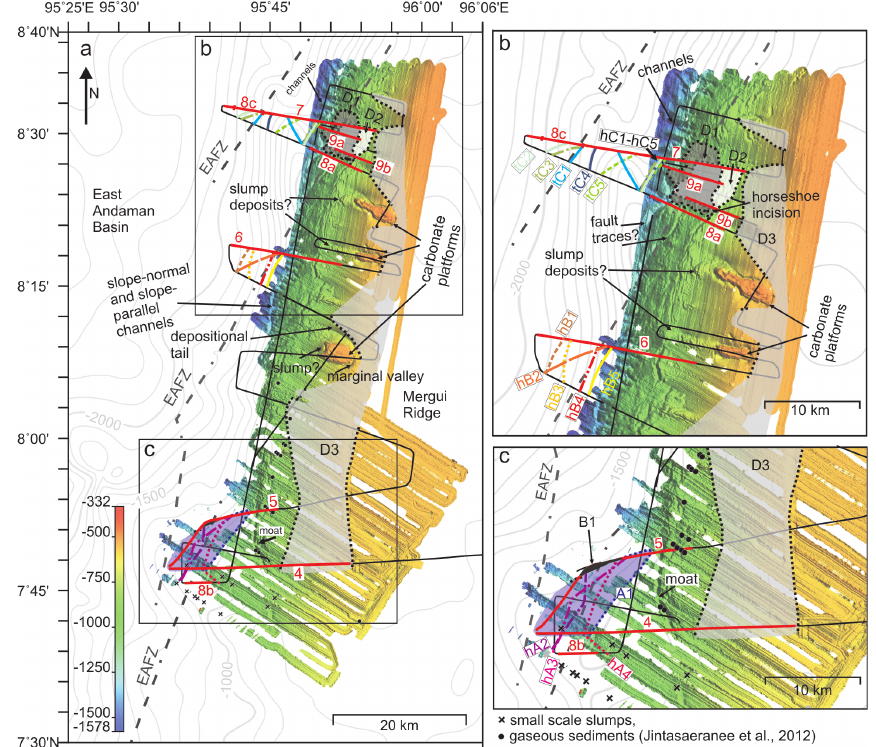
Fig. 3. (a) Bathymetric map of the working area (from Jintasearanee et al., 2012) with contour lines from SRTM30 PLUS (Becker et al., 2009). The interpretation of several morphological features, carbonate platforms, slump deposits, fault traces, as well as the positions of small scale slumps and gas-bearing sediment are taken from Jintasaeranee et al. (2012) as well. The black continuous lines show the cruise track and the red lines indicate the seismic profiles shown in this study. The grey shaded areas on the Mergui Ridge mark the areal extents of MTDs D1–D3, the black stippled lines show the slide margins where they were interpolated. The grey dotted lines indicate positions of branches of the EAFZ (from Polachan, 1988). (b) Close-up of the northern working area. The coloured dotted lines indicate heads (hB1–hB5 and hC1–hC5) and toes (tC1–tC5) of individual MTDs, as mapped from the seismic data. The grey shaded areas show the extents of the Mergui Ridge-MTDs D1–D3. (c) Close-up of the southern working area. The purple shaded area indicates the areal extent of MTD A1. The purple dotted line indicates the slide margins where they were interpolated. The dark grey block indicates the position of a potential in-situ block (B1, see also Fig. 5) or the slide margin north of A1. The coloured dotted lines denote the interpolated heads of MTDs A2–A4